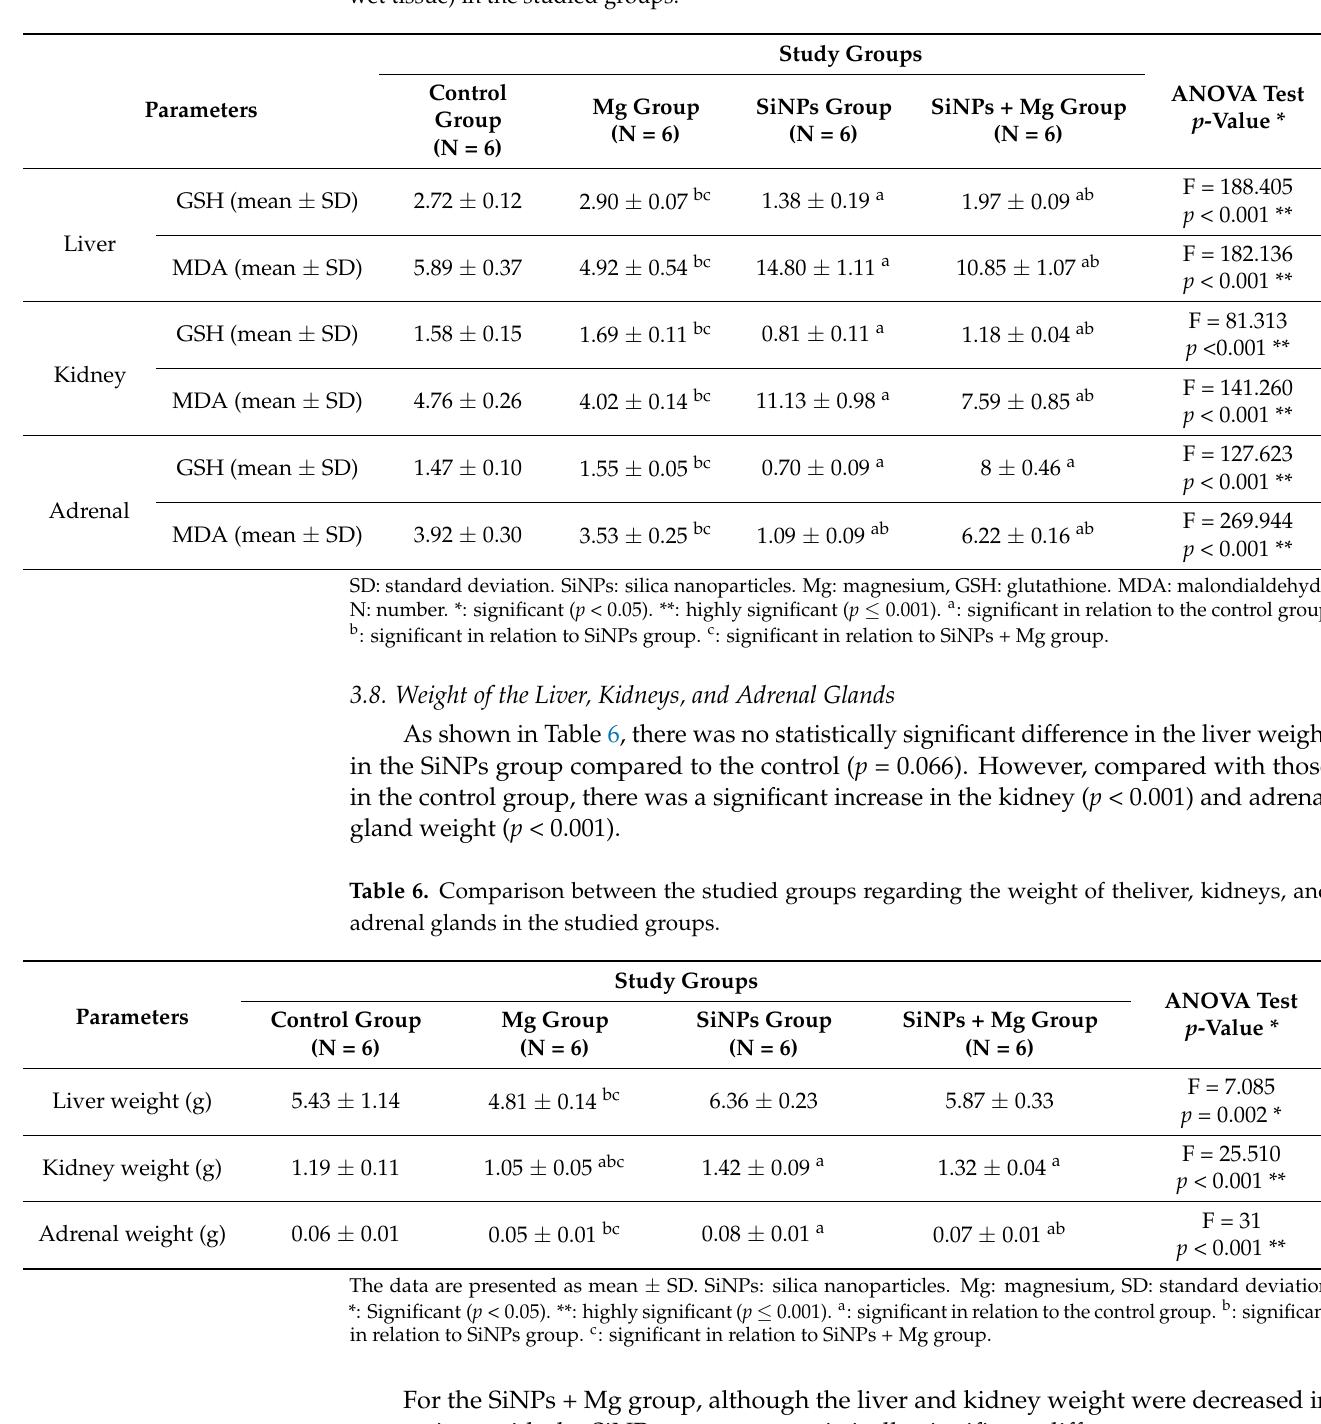
Table 5. Comparison between the studied groups regarding tissue levels of GSH and MDA (mmol/g wet tissue) in the studied groups.